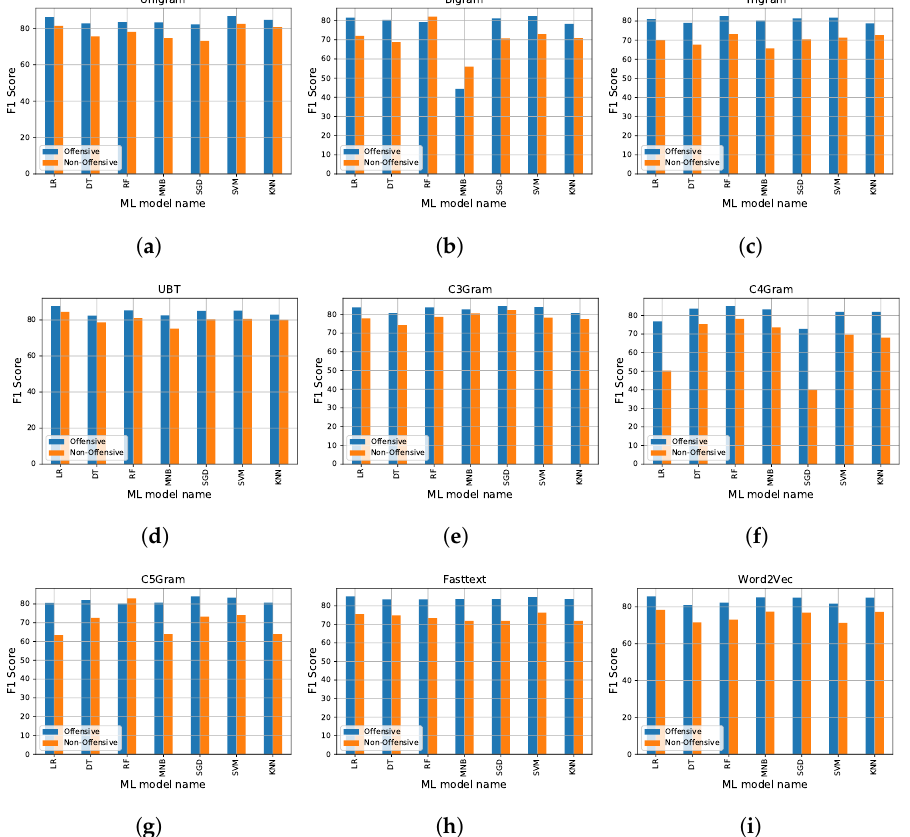
Figure 8. F1-score of various baseline methods on test